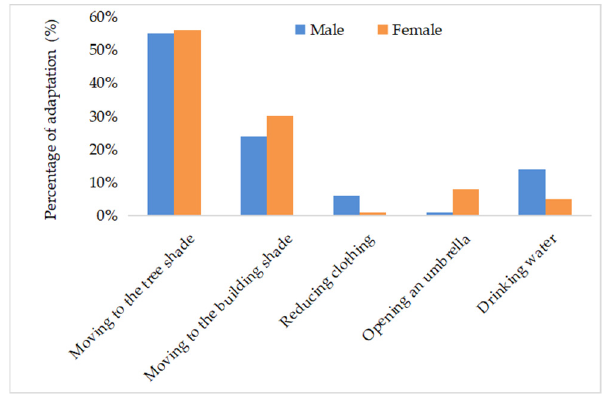
Figure 12. Frequency distribution of thermal adaptation behaviors.